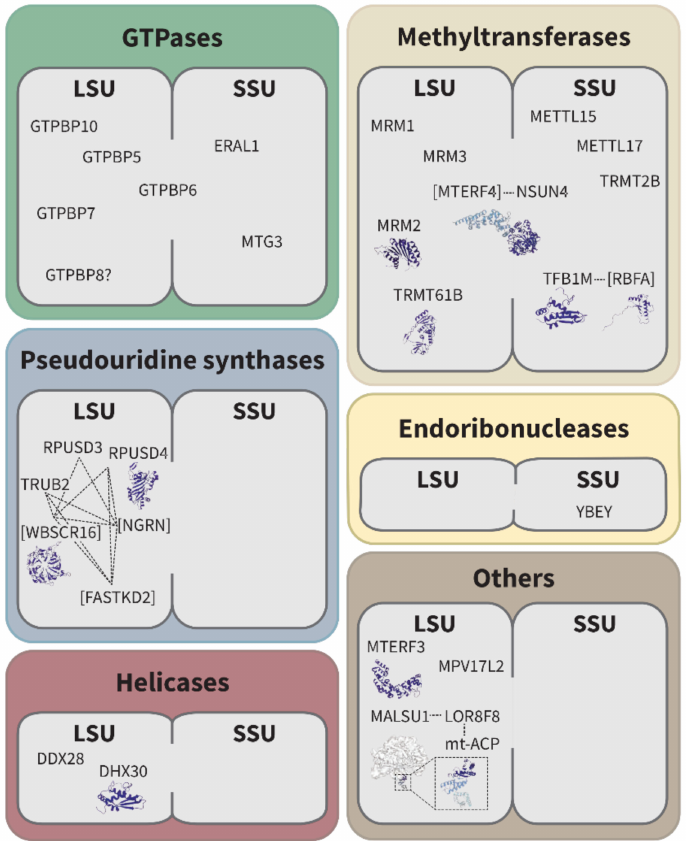
Figure 3. Mitoribosome assembly factors. Mitoribosomal assembly factors and their functional partners. Assembly factors without known enzymatic activity are termed “others”. Certain assembly factors are known to work in protein modules and are thus represented together and connected by dashed lines (NSUN4-MTERF4 [24–26]/TFB1M-RBFA [27]/RPUSD3-RPUSD4-TRUB2-WBSCR16- NGRN-FASTKD2 [28,29]). Factors of protein modules, which do not possess the corresponding enzymatic activity, are indicated in squared brackets. Even though RPUSD3 and TRUB2 are pseu- douridine synthases, their activity toward 16S rRNA could not be demonstrated so far. GTPBP8 is speculated to participate in the assembly process due to its homology with the bacterial assembly fac- tor. For all other proteins, some experimental evidence exists for their involvement in mitoribosome biogenesis. Available structures are depicted (RPUSD4 (pdb 5UBA), WBSCR16 (pdb 5XGS), DHX30 (pdb 2DB2), MRM2 (pdb 2NYU), TRMT61B (pdb 2B25), TFB1M (pdb 6AAX), RBFA (pdb 2E7G), NSUN4-MTERF4 (pdb 4FP9), and MTERF3 (pdb 3M66)). In the context of the mitoribosome, there